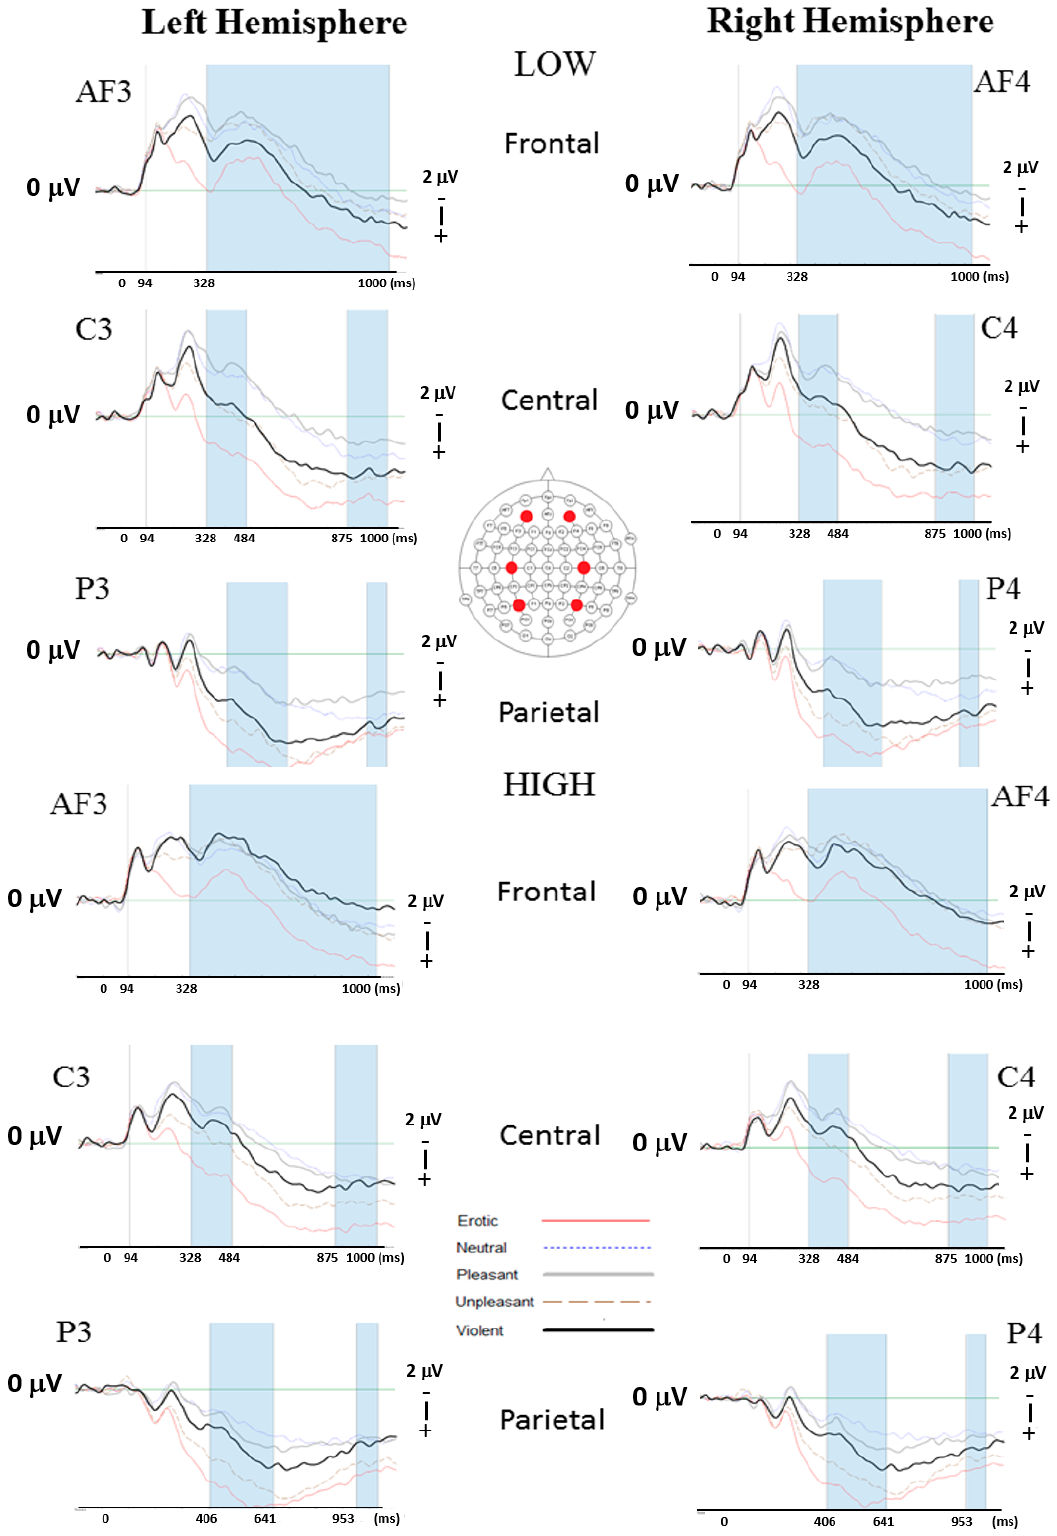
Figure 3. Event-related potential (ERP) effects representing frontal (AF3/AF4), central (C3/C4) and parietal (P3/P4) locations across all emotion categories for low and high aggression use groups. Note significant effects for ‘pleasant’ versus ‘violent’ emotion categories between 94 and 1000 ms in frontal areas of the brain and between 328 and 1000 ms in the central and parietal regions.